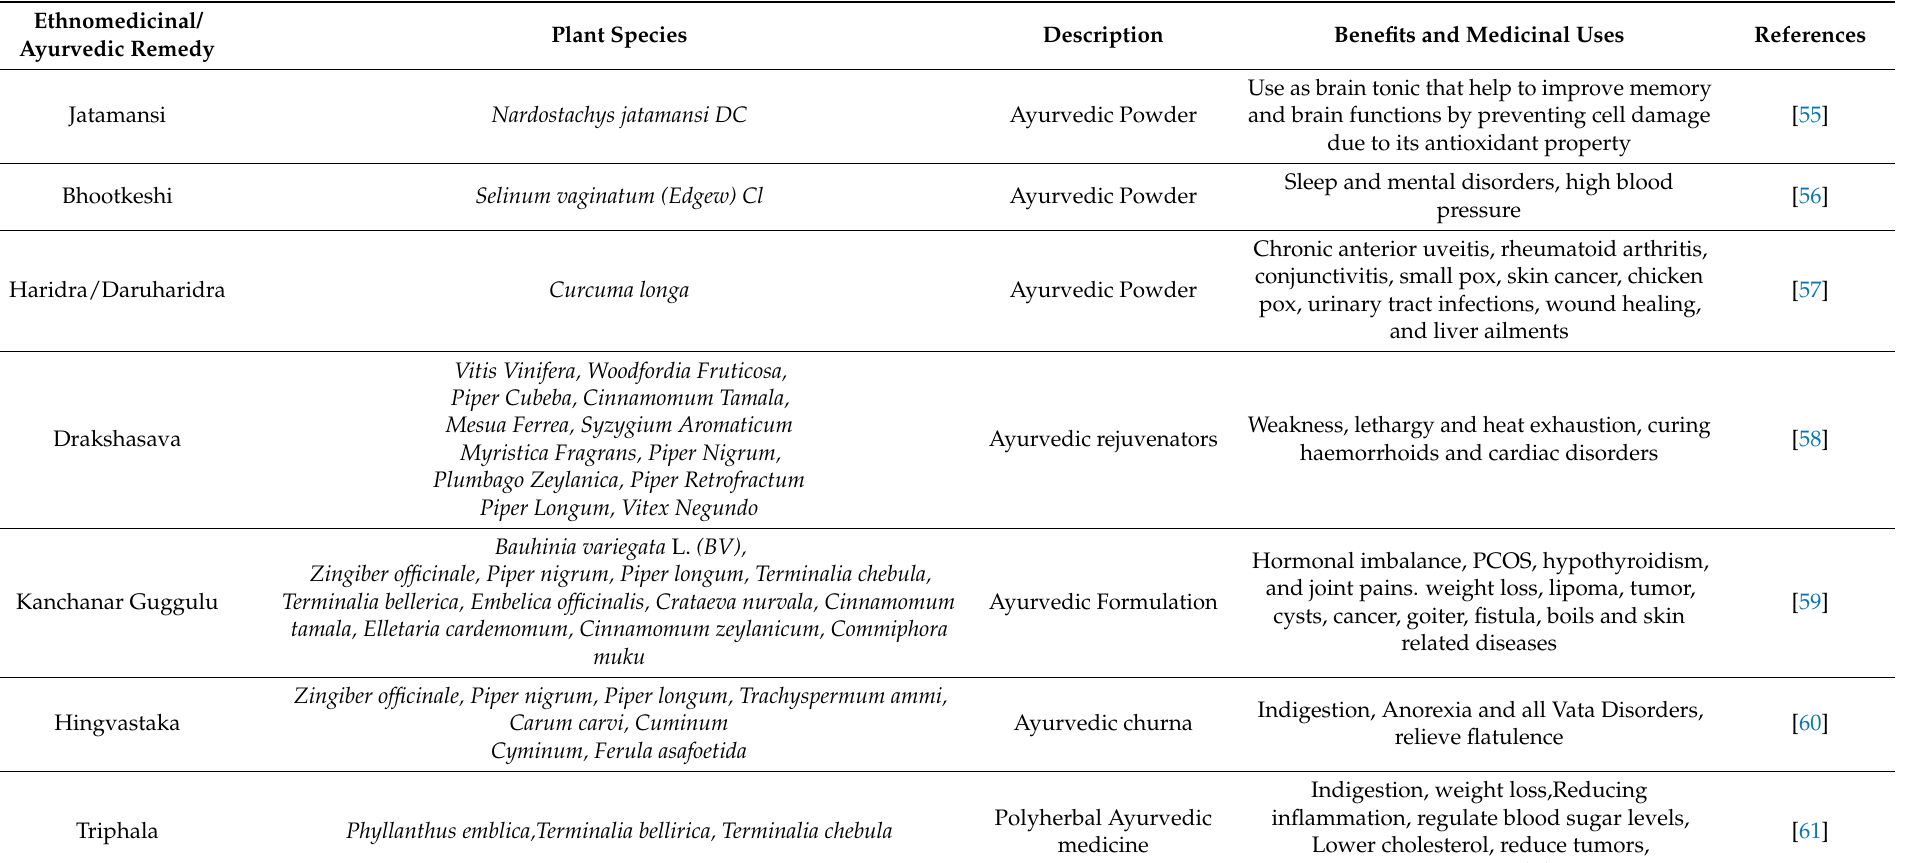
Table 2. Some popular Indian ethnomedicinal/Ayurvedic remedies and their